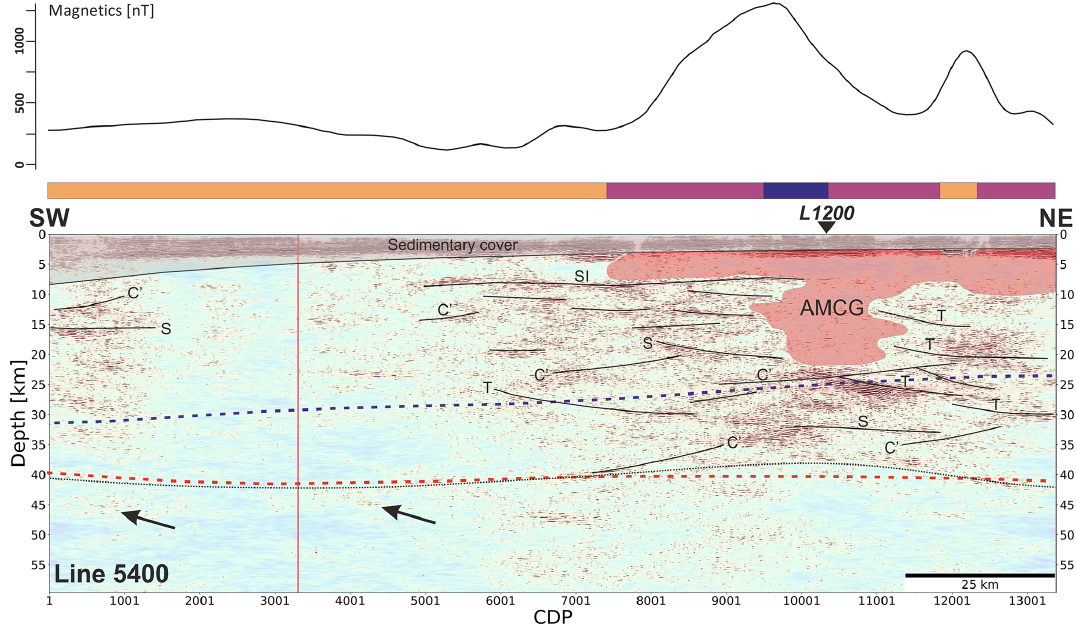
Figure 8. Final migrated depth-converted sections along PolandSPAN ™ profile 5400 with its tentative interpretation. Bars atop the section are colour-coded according to the crystalline basement lithologies following Krzemi´nska et al. (2017) (see Fig. 9 for a legend). The magnetic profile at the top is extracted from the magnetic anomaly map (Fig. 3). S – subhorizontal structural layering (Svekofennian orogenic fabric); T – ductile thrust shear zones; C (cid:48) – extensional shear